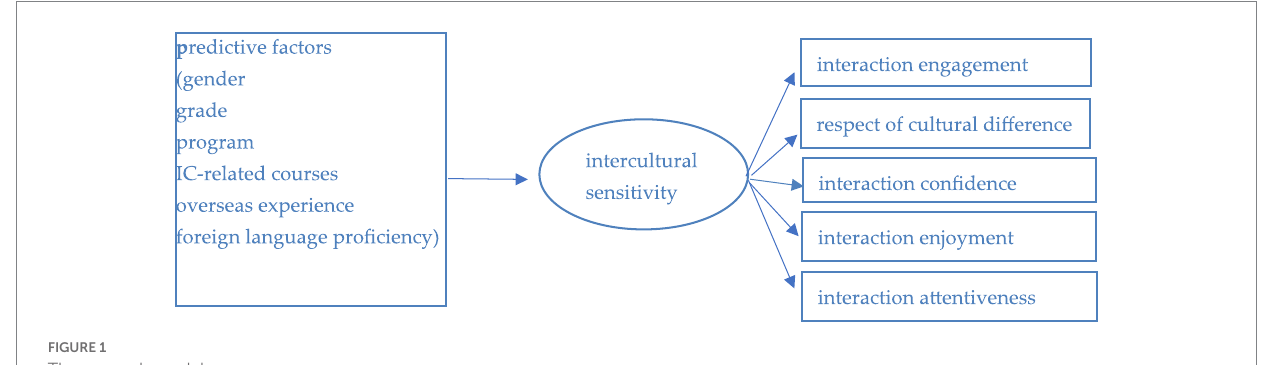
FIGURE 1 The research model.